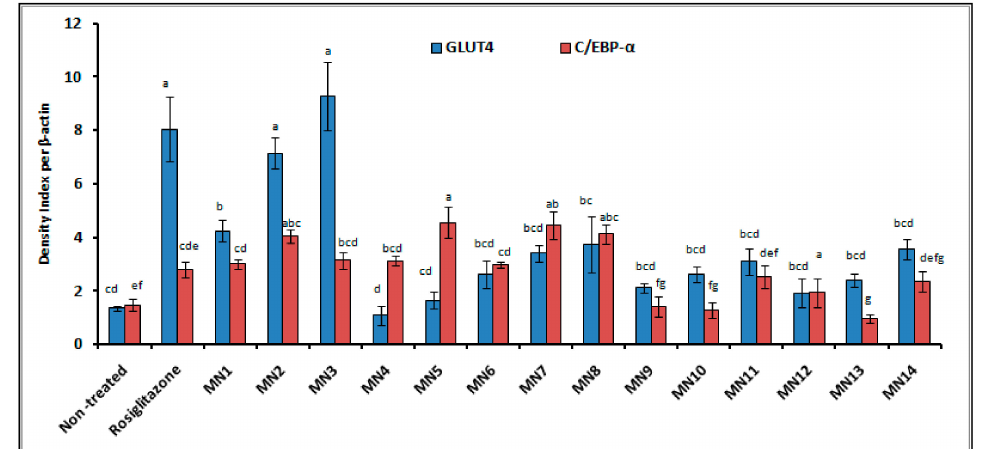
Figure 10. The density of protein bands of GLUT4 and C/EBP- α per β -actin. Mean ± S.D., n = 3, mean values that do not share a letter are significantly different ( p < 0.05).